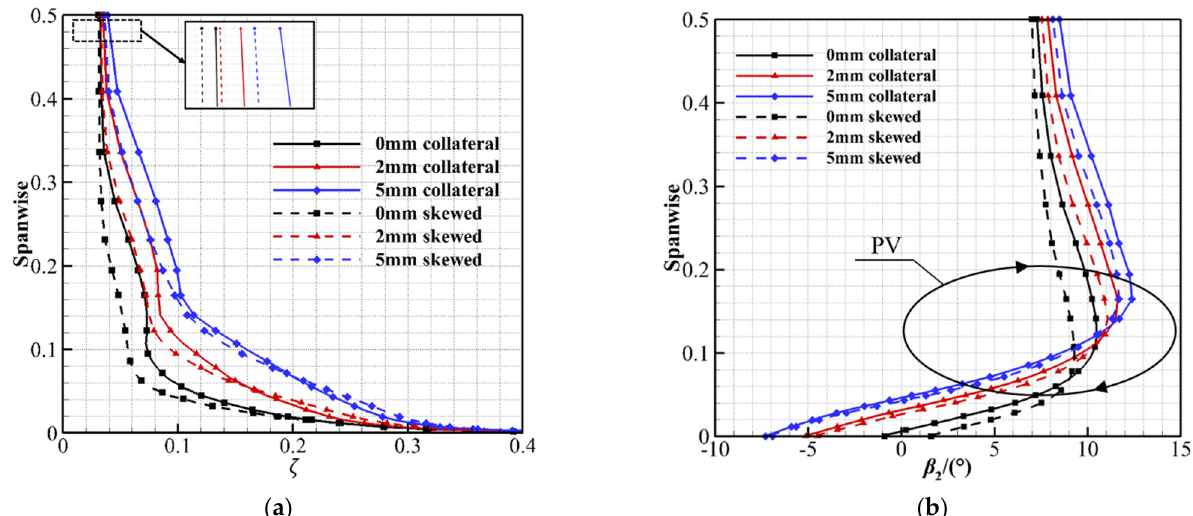
Figure 11. The distributions of mass pitch-averaged outlet total pressure loss coefficient and outlet flow angle of the original cascade along the spanwise: ( a ) Total pressure loss coefficient; ( b ) Outlet flow angle.